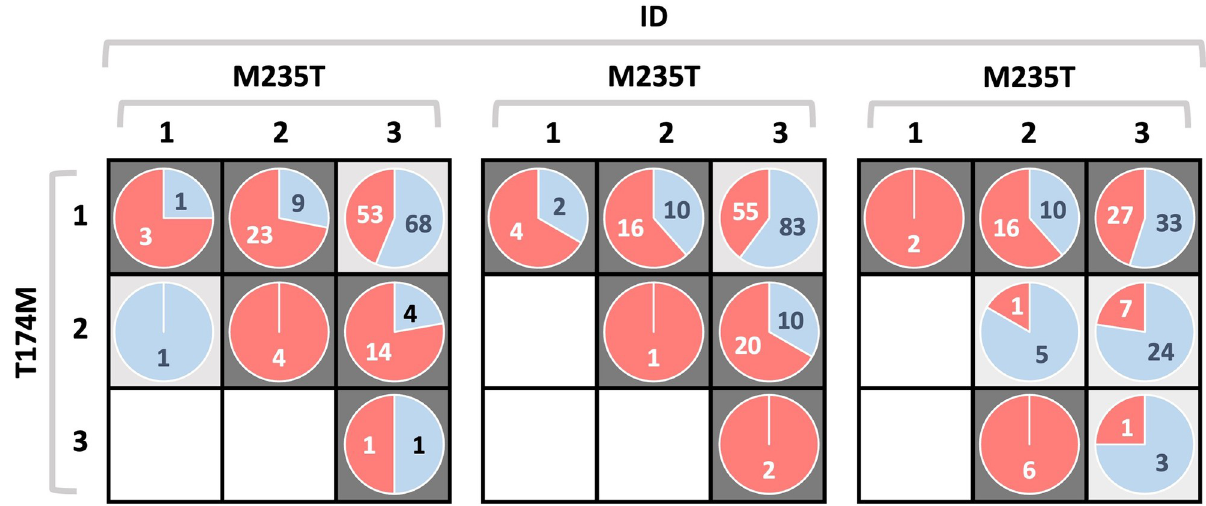
Fig 9. Simulated atrial fibrillation data. Schema of the distribution of cases (red section of the pie-plots) and controls (light blue section) in the case- control study described in [46], for each multilocus genotype combination of M235, T174M and ID. Dark gray cells are associated to higher risk of atrial fibrillation, while light gray cells are associated to protective combinations. The schema proposed here is based on the image reported in [45].